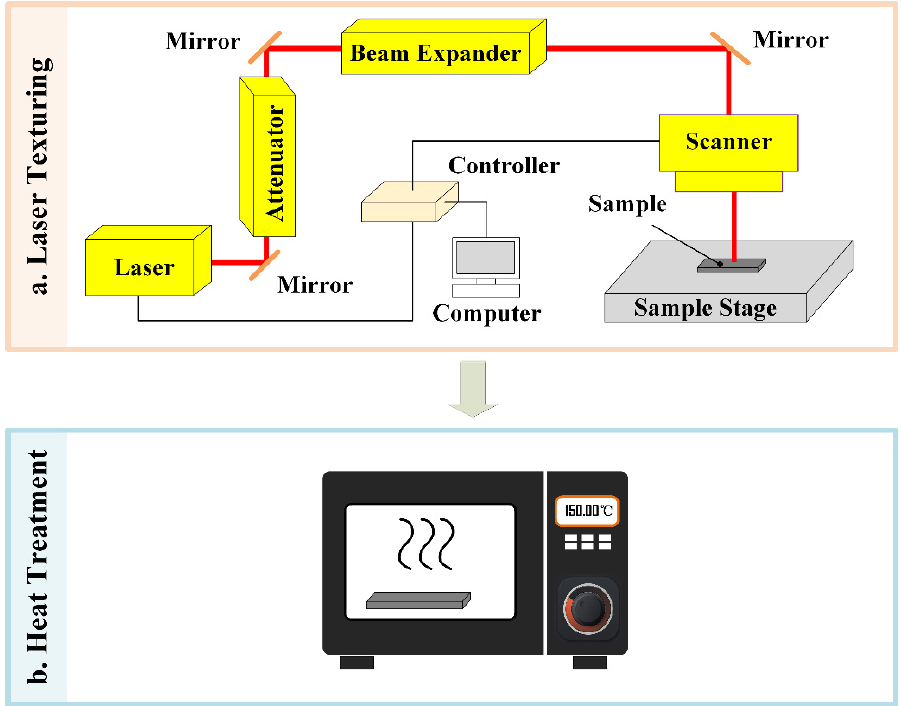
Figure 2. Schematics for the laser-based surface texturing experiments of BMG: ( a ) laser surface texturing; ( b ) heat treatment. Table 1. Processing parameters for the laser-based surface texturing experiments.